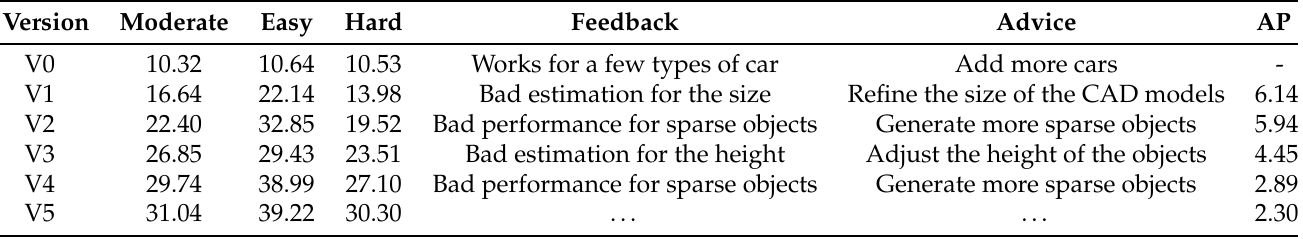
Table 3. The process of updating the ShapeKITTI